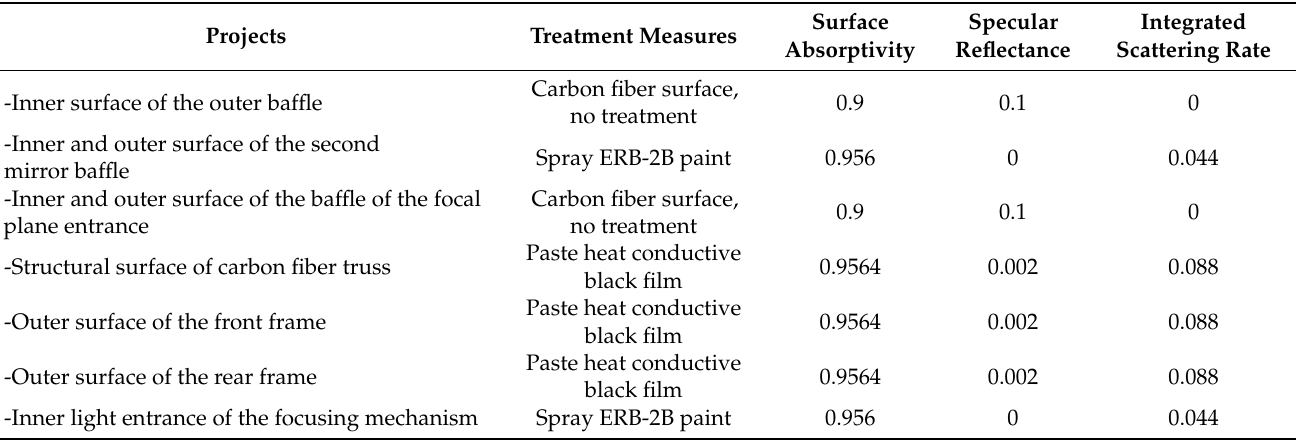
Table 3. Stray-light suppression measures and surface properties on the inner surface of the large off-axis TMA space